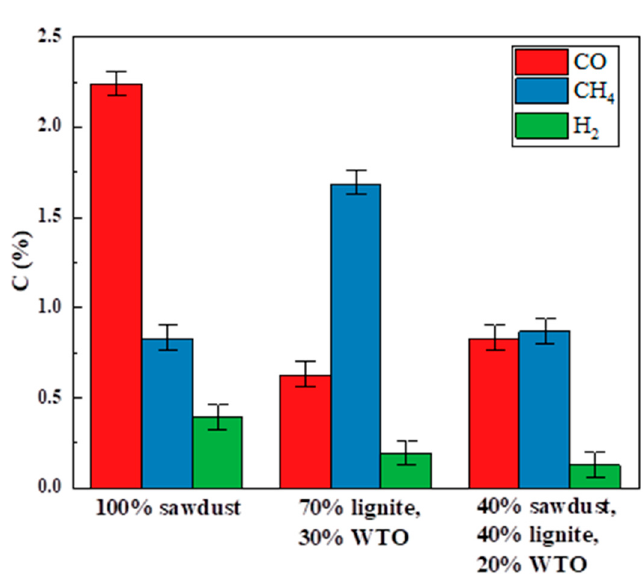
Figure 3. The content of combustible components in the syngas composition. The presence of water vapor molecules in the gasifier reactor is due to the release of hydrated and pyrogenetic moisture during the solid fuel thermal decomposition. During the sawdust gasification, a greater amount of water vapor was released, compared to